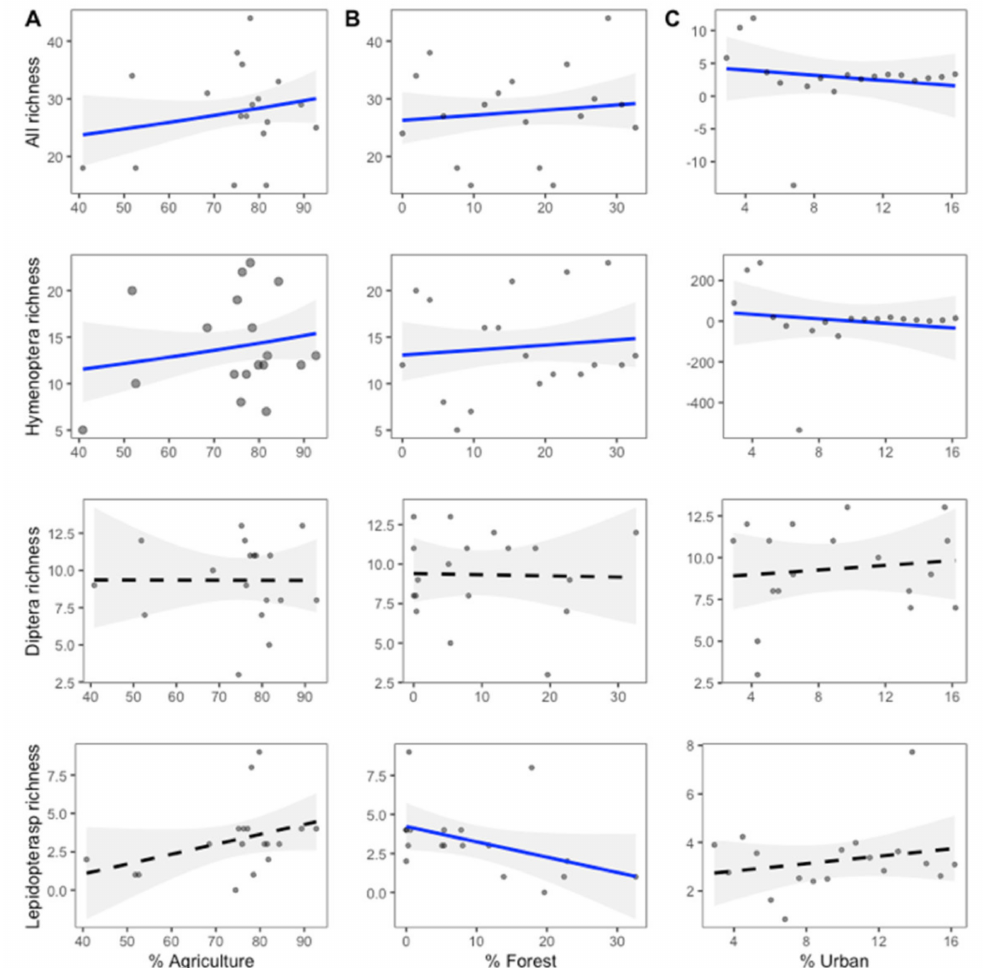
Figure 4. Pollinator richness in relation to the percentage of ( A ) agriculture, ( B ) forest, and ( C ) urban landscape within a 3 km radius from each study site. All regressions are plotted with 95% corresponding confidence intervals (scales have been optimized for each set of analysis and thus vary between plots). Solid blue lines indicate significant associations ( p < 0.05), whereas dashed lines indicate non-significant relationships ( p > 0.05). For statistics, see Supplementary Material Table